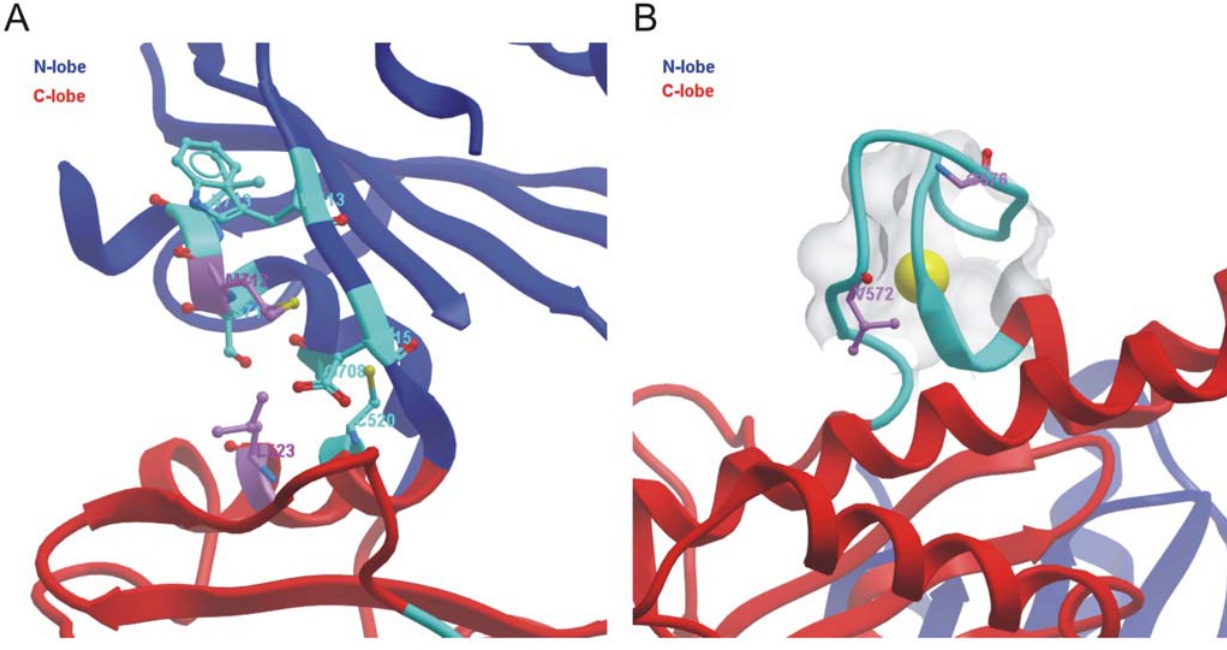
Figure 8. Disease-related mutations in the GNE kinase domain. Panel A: M712 and its surrounding environment. M712 is within 4 A˚ with the side chain of L523 and forms hydrophobic interaction. Panel B: Disease-related mutations at residues V572 and G576 are located in the zinc-binding